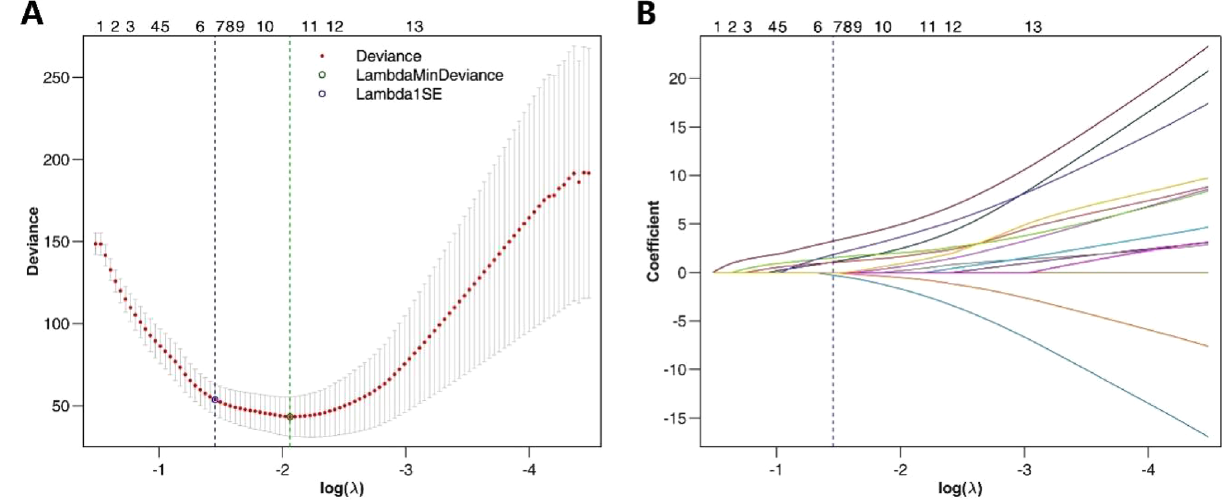
Figure 1. LASSO logistic regression plot. ( A ) Plot of partial likelihood deviance; ( B ) plot of LASSO coefficient profiles. Each colored curve represents the LASSO coefficient profile of a feature against the log (λ)